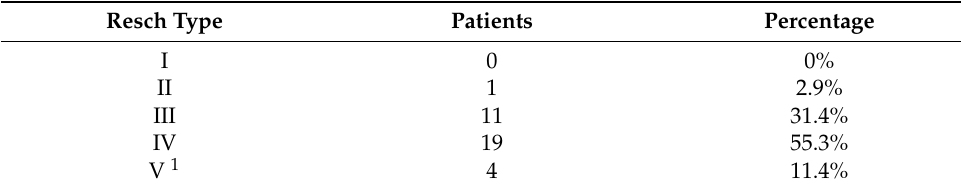
Table 1. Fracture classification according to the Resch